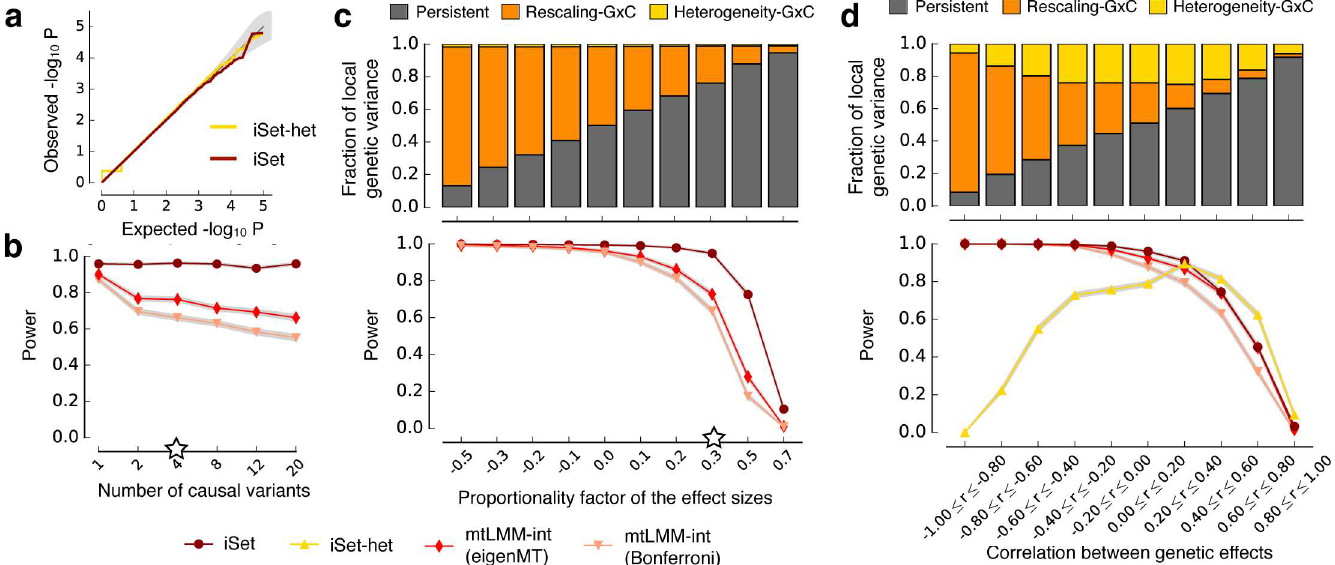
Fig 2. Simulated data to assessstatistical calibration and power of iSet. (a) QQ plot for the P values obtainedfrom iSet and iSet-het when only persistent genetic effects were simulated.The step in the QQ-plot for large p-values is observedbecausethe trait-context covariances are requiredto be positive-semidefinite. (b) Power comparisonof alternative models for detecting simulatedinteractions, considering rescaling-GxC effects (without heterogeneity-GxC) for increasingnumbers of simulatedcausal variants at constant total geneticvariance.Comparedwere iSet and a single-variant interactiontest (mtLMM-int) [10], using two alternativeapproaches to adjust for multiple testing of single variant methods (Bonferroni or eigenMT). (c) Lower panel: analogous power comparison as in b, when varyingthe proportionality factor of effect sizes betweencontexts. A proportionality factor of zero correspondsto genetic effects that act only in one of the contexts. See S3 Table for the relationshipof the proportionality factor and fold differences. iSet- het was not considered, becauseall simulatedrescaling-GxC are consistent with the null model of iSet-het. Top panel: averagefraction of geneticvariance attributableto persistent, rescaling-GxC and heterogeneity-GxCeffects for the corresponding simulations. (d) Analogouscomparisonas in c but for simulatedheterogeneity-GxC effects, when varyingthe correlationof the total genetic effect betweencontexts. Additionally,we also considered iSet-het to test for heterogeneity-GxC, which was best poweredfor heterogeneity-GxC effects that were uncorrelated between contexts. White stars denotedefault parameter values that were kept constant when varyingother parameters( S2 Table ). Statistical power was assessedat 5% FDR across 1,000 repeat